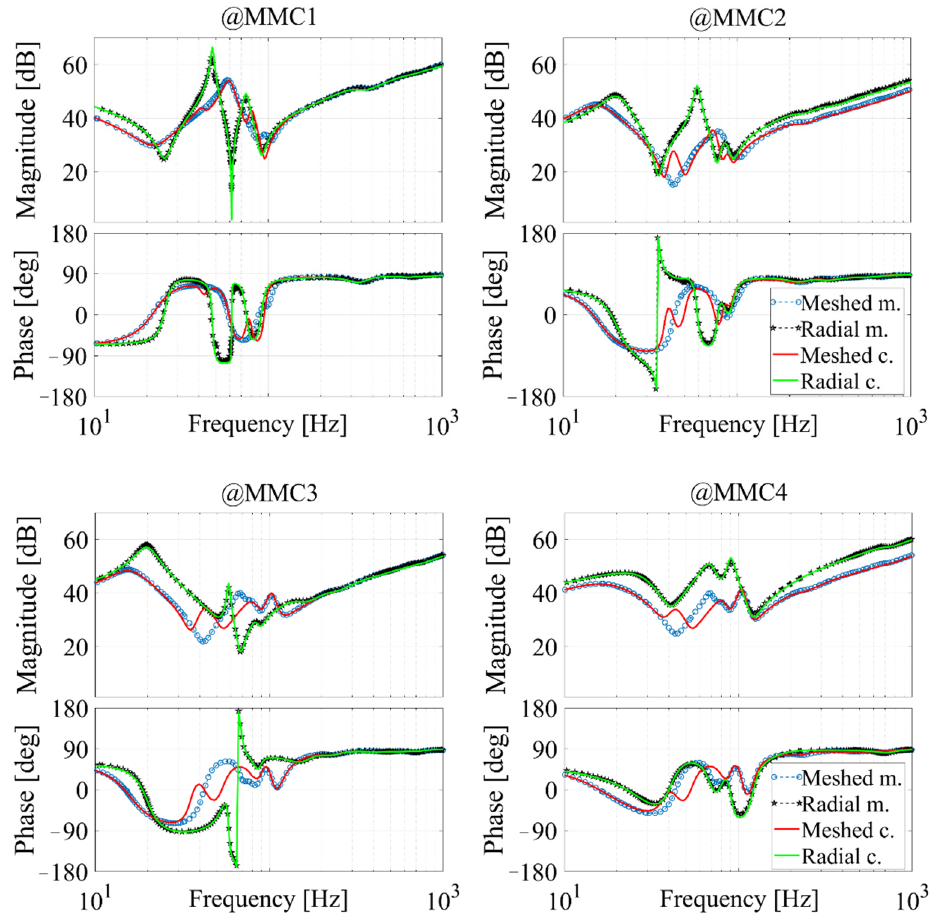
Figure 10. Measured vs. calculated radial (black vs. green) and meshed (blue vs. red) network equivalent impedance seen from the four different MMCs.